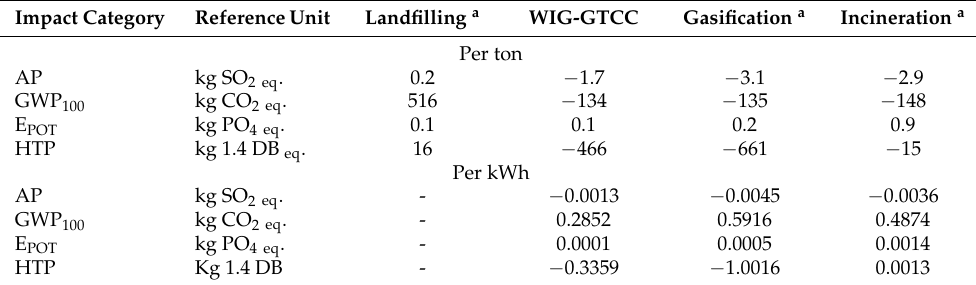
Table 5. Impact indicators per ton and kWh of MSW disposed of/valorized. Impact